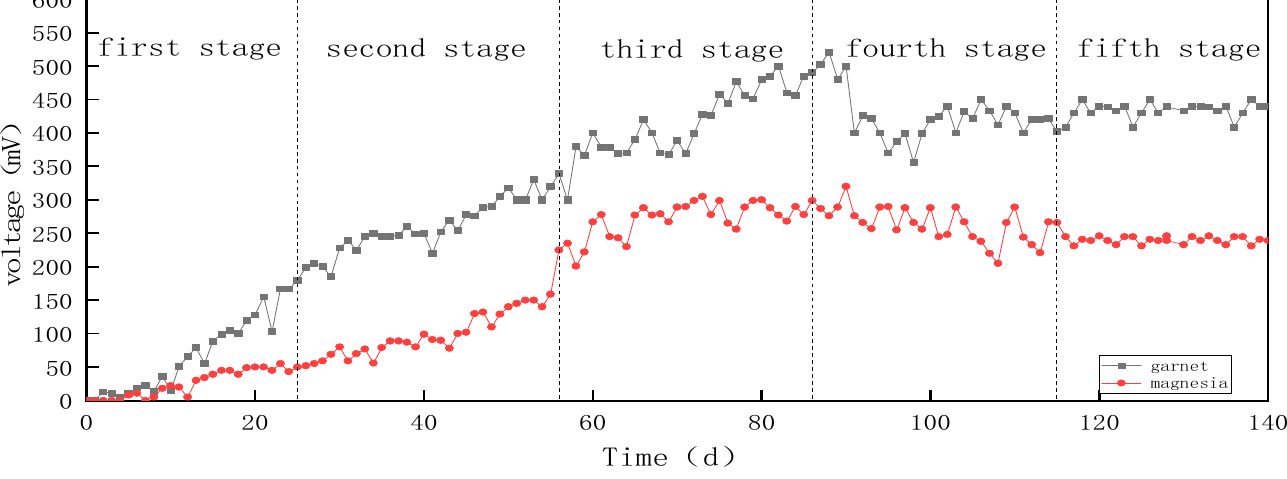
Figure 3. Daily voltage changes during the CW-MFC stages.